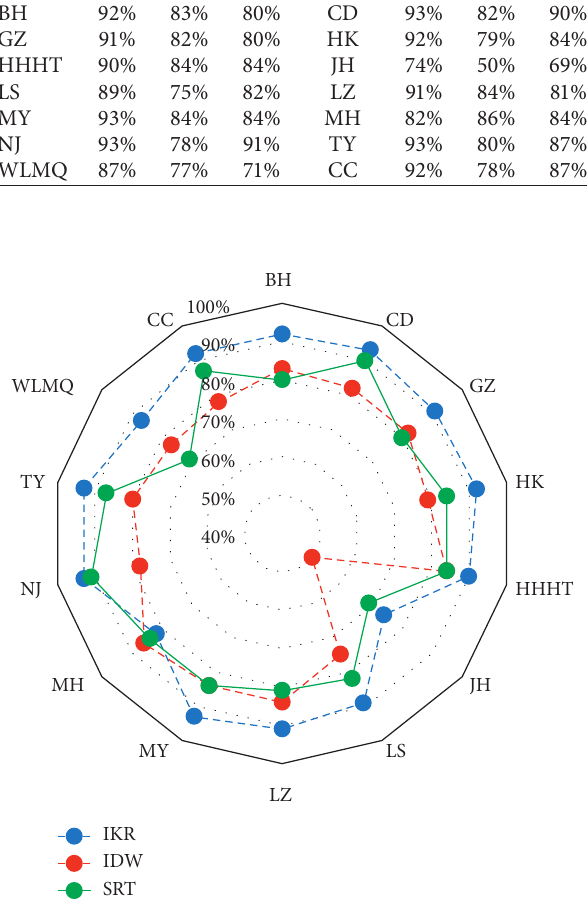
Figure 9: Error detection rate under the best QC parameters in the 14 regions of the